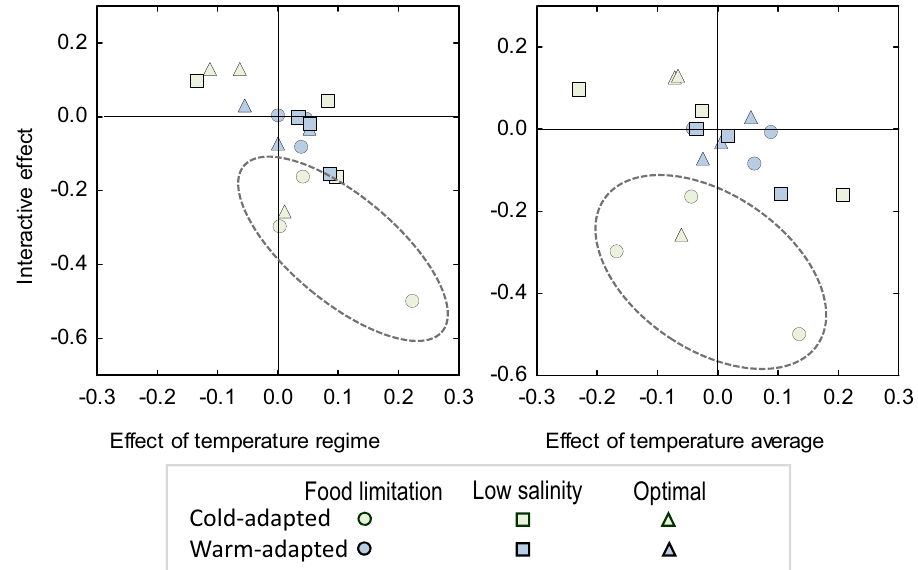
Fig. 6 Space-state representation of the survival responses. Survival (log-transformed data) was quanti fi ed in larvae exposed to the ‘ heatwave treatment ’ for the native (light green symbols) and invasive crab (blue symbols). The 3D representation is decomposed in 2D plots: x-axes represent f 1 and f 2 , i.e. giving the contribution of the temperature regime (left panel) or the temperature level (right panel); y-axis represents g , giving the contribution of the interactive ‘ heatwave effect ’ (i.e. an event characterised by high temperature in terms of average and variability). The reference condition was the treatment of low and constant temperature. Calculations were performed separately for the three environmental conditions: food limitation (but optimal salinity), optimal food access and salinity, low salinity (but optimal food access). Each point represents an average response exhibited by a group of larvae produced by a speci fi c female and exposed to a speci fi c combination of food and salinity. Negative values in the interacting effect correspond to decreases in survival under the heatwave treatment as compared to other temperature treatments. Dashed circles highlight responses to the simulated heatwave for the native crab. A similar representation is obtained with the data is in the raw scale (Supplementary Fig.